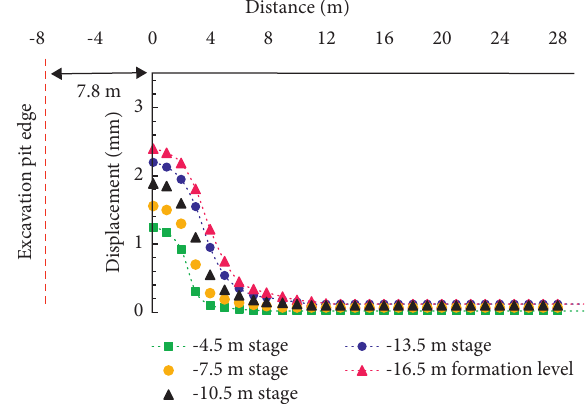
Figure 13: Relative ground displacement from 30# bridge pile group foundation with the application of the servo steel geo- technology axial loading support capacity